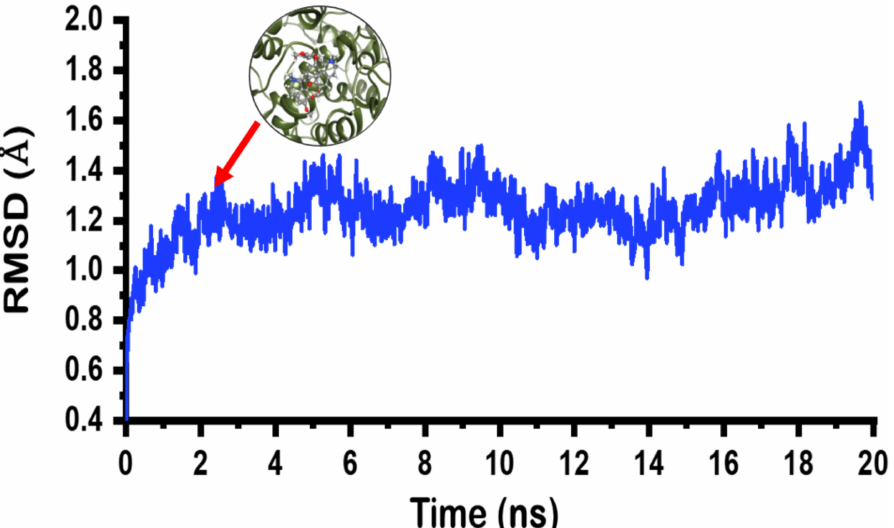
Figure 5. RMSD of the docked poses of limacusine ( 2 ). The x -axis is showing time in nanoseconds while the y -axis is showing RMSD in angstrom (Å).